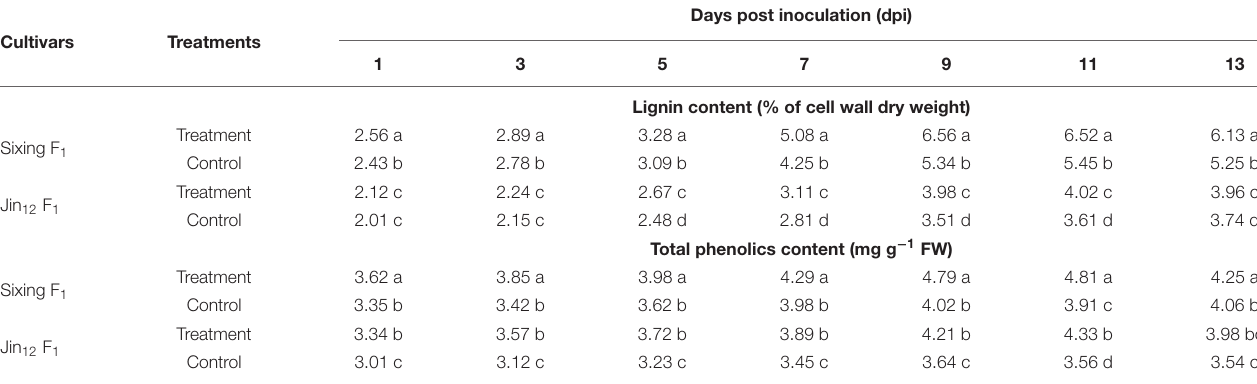
TABLE 4 | Lignin and total phenolic content in different cultivars of Cucurbita pepo seedlings after inoculation with Podosphaera xanthii.